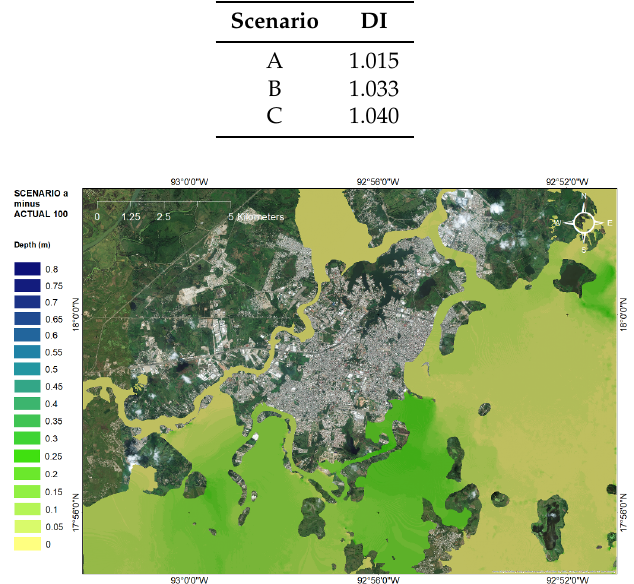
Table 6. Depth Index (DI) computed for the three future urban scenarios.